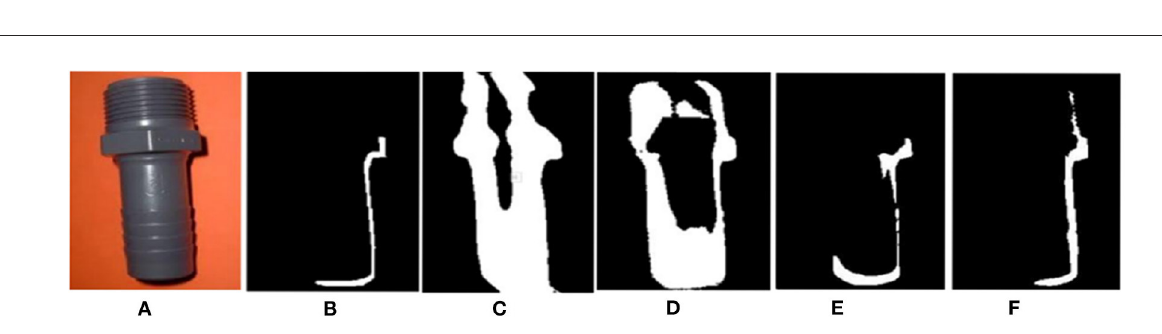
n N s ( p ) corresponding to the bright region. V ′ p is the result